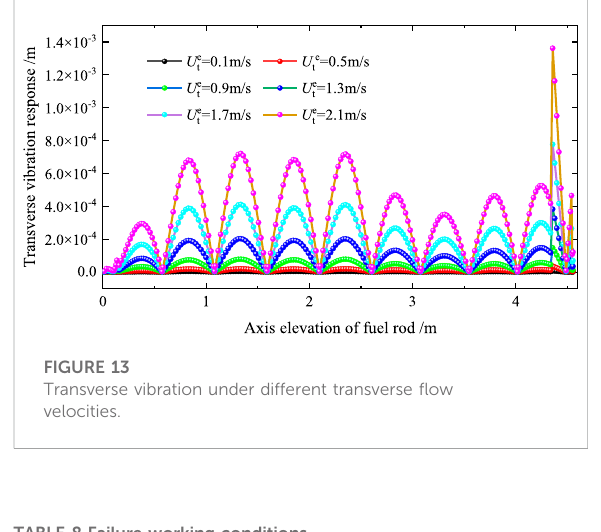
FIGURE 14 Natural frequency under clamping failure and no clamping